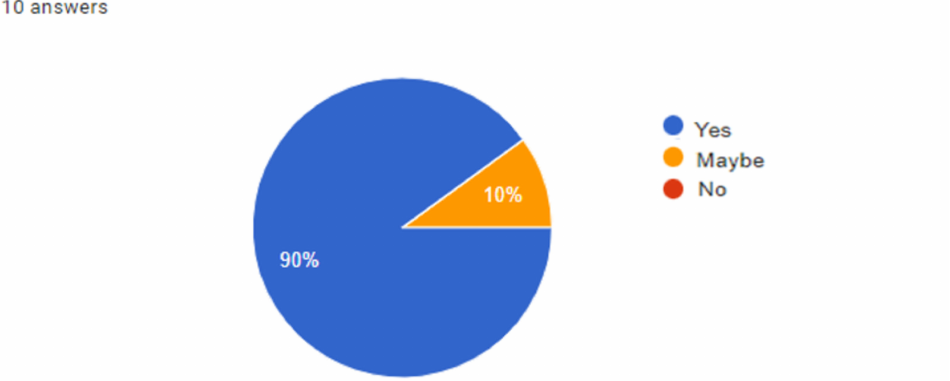
Figure 16. Promotion of the model (NPS) for external